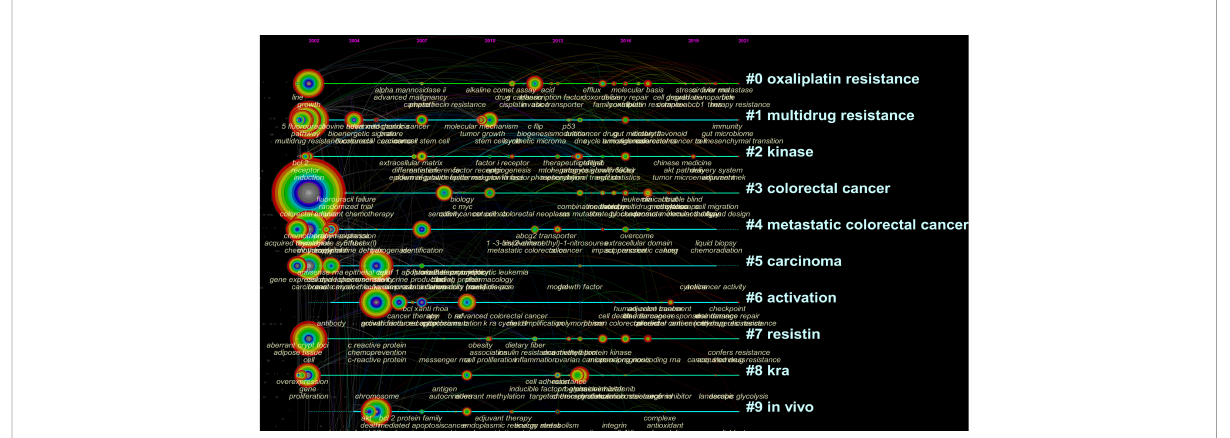
FIGURE 9 A timeline view for keywords associated with colorectal cancer drug resistance. The node ’ s position on the horizontal axis represents the time when the keyword fi rst appeared, and the node ’ s size is positively correlated with the number of occurrences of the keywords. The lines between the nodes represent co-occurrence relationships. The redder the color means closer to 2021, and the grayer the color means closer to